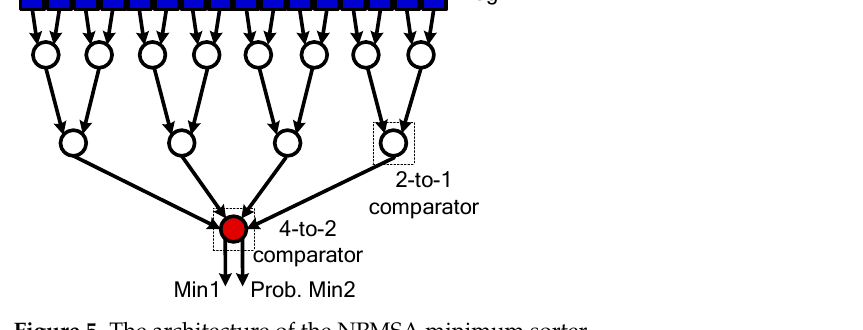
Figure 5. The architecture of the NPMSA minimum sorter.